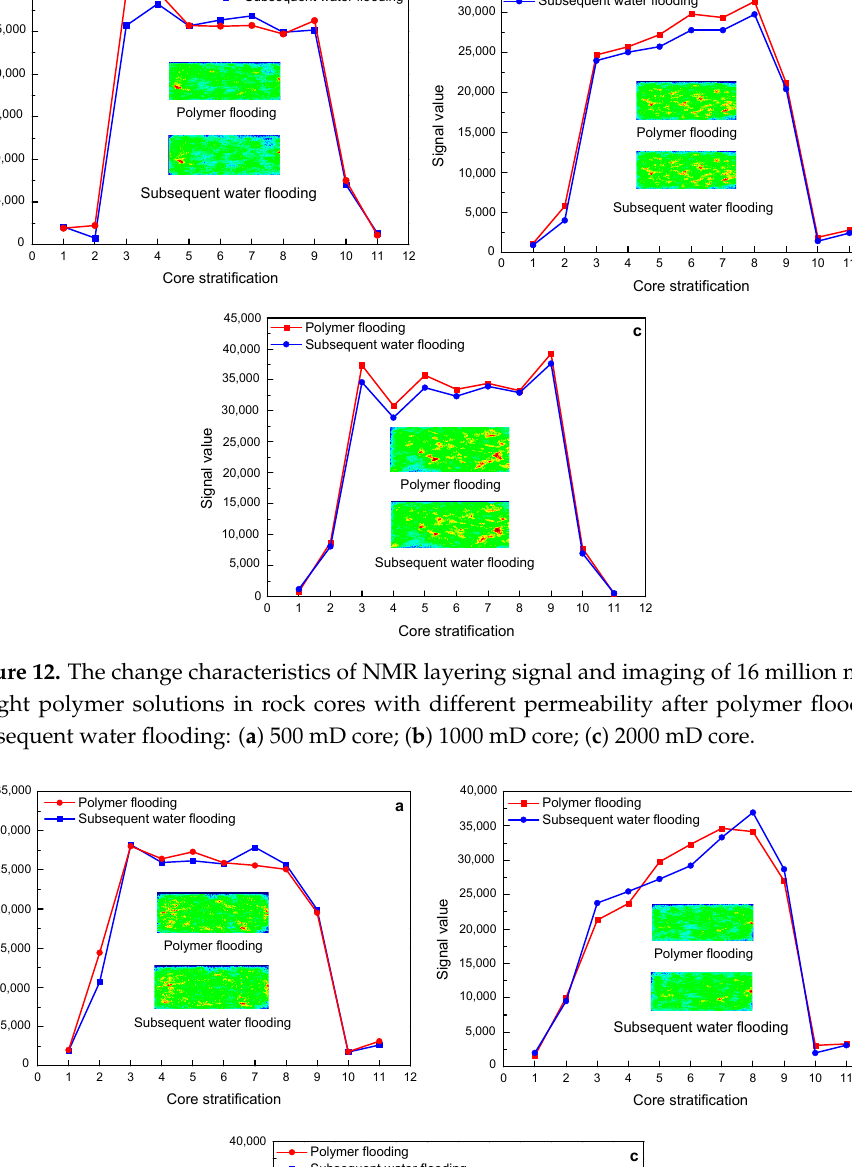
process of three different permeability. Similar to the polymer solution with a molecular weight of 16 million, the subsequent water flooding and polymer flooding have basically the same signal values of each layer of nuclear magnetic resonance, and the fluid distri- bution on imaging is also basically the same, which is consistent with the results of the NMR T 2 spectrum curve.